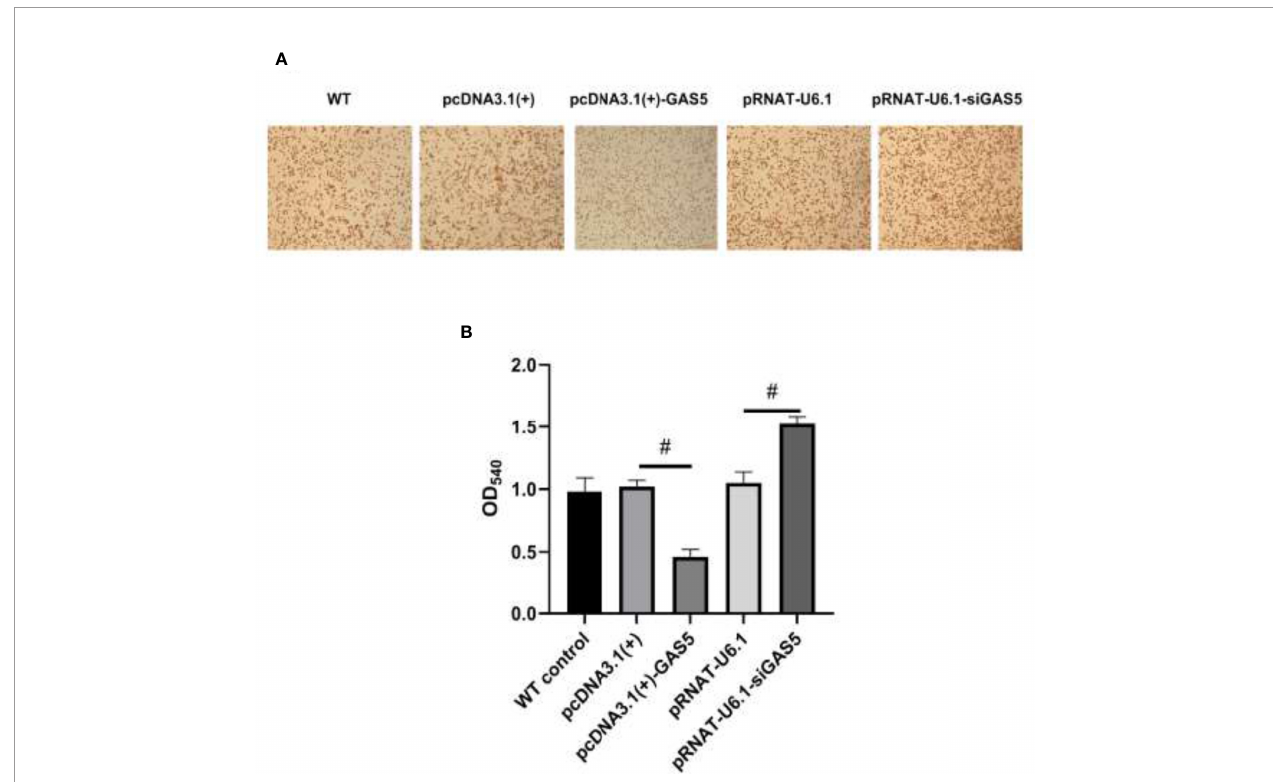
FIGURE 6 | GAS5 inhibits the phagocytic activity of RAW264.7. (A) The cytological morphology of RAW264.7 from neutral red uptake assay at 24 h in the fi ve groups. (B) Semiquantitative analysis of the phagocytosis of RAW264.7. Statistical signi fi cance was determined by the Student ’ s t -test ( # p <